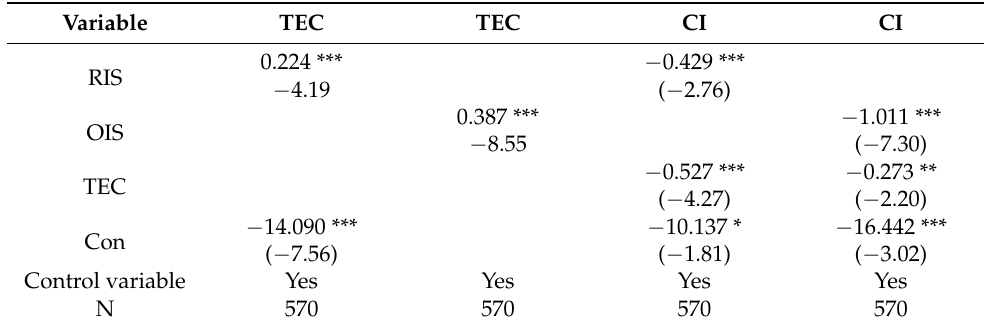
Table 4. Regression results from the mediating effect of technological